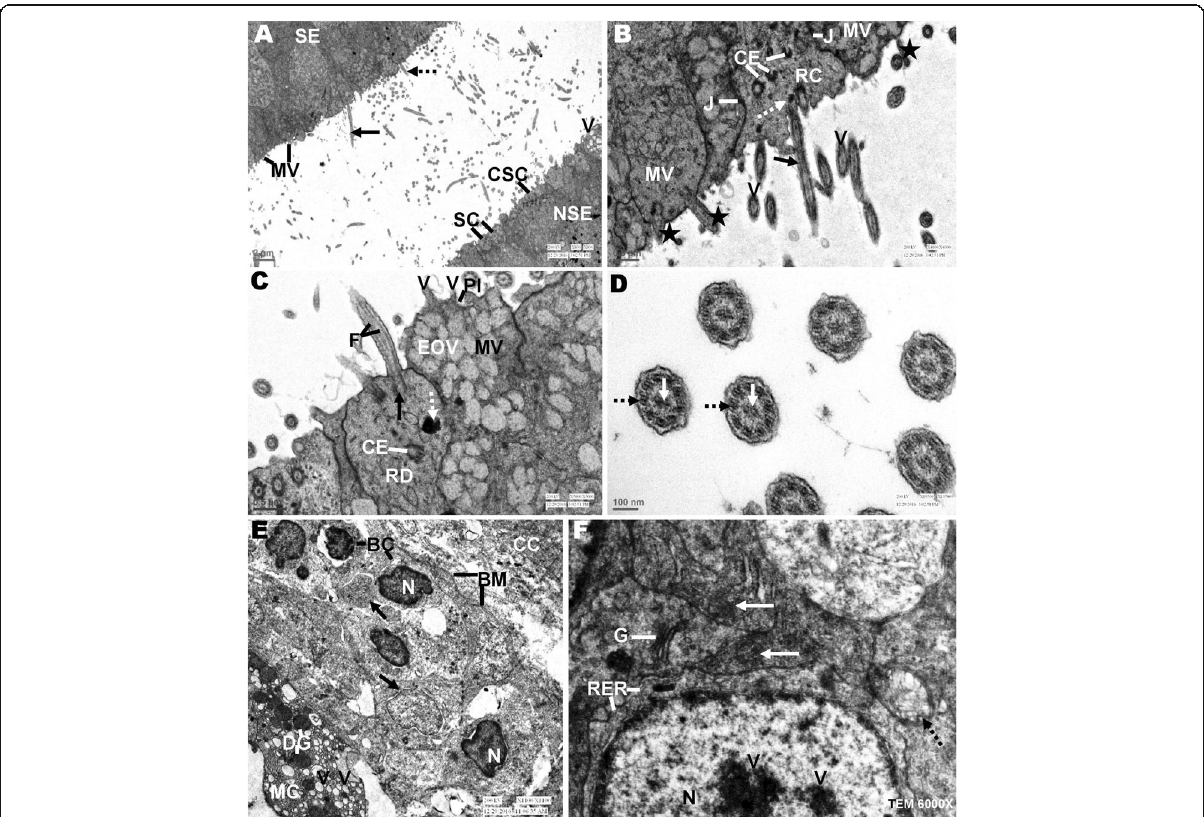
Fig. 5 Photomicrographs of the olfactory lining of E. vacha by transmission electron microscopy (TEM). A Sensory epithelium (SE) contains ciliated receptor cell (solid arrow), microvillous receptor cells (MV), and rod cell (broken arrow) while nonsensory epithelium (NSE) with nonciliated supporting cell (SC), ciliated supporting cell (CSC), and mucous cell (arrow head). B Sensory part shows MV with minute microvilli (asterisks), ciliated RC with dendrite process of (solid arrow) arises from basal body (broken arrow) and centrioles (CE). RC exhibits junctional complex (J) with neighboring cells. Arrow heads indicate cross section of cilia. C Sensory epithelium illustrates MV with electron opaque vesicles (EOV), minute microvilli (arrow heads), and pinocytotic invagination (PI) on apical surface. Rod cell (RD) exhibits spike-like projection having parallel arranged microfilaments (F) emerged from basal body (solid arrow), centriole (broken arrow), and electron-dense vesicle (broken arrow). D Transverse section of cilia shows 9 pairs of peripheral microtubules (broken arrows) and 2 central ones (solid arrows). E Nonsensory mucosa shows basal cells (BC) with nuclei (N), mast cells (solid arrows), and mucous cell (MC) with dense granules (DG) and vacuoles (arrow heads). Note the basement membrane (BM) in between mucosa and central core (CC). F Nucleus (N) of basal cells having fragmented heterochromatin (arrow heads) surrounded by rough endoplasmic reticulum (RER). Note the presence of mitochondria (solid arrows) and Golgi apparatus (G)